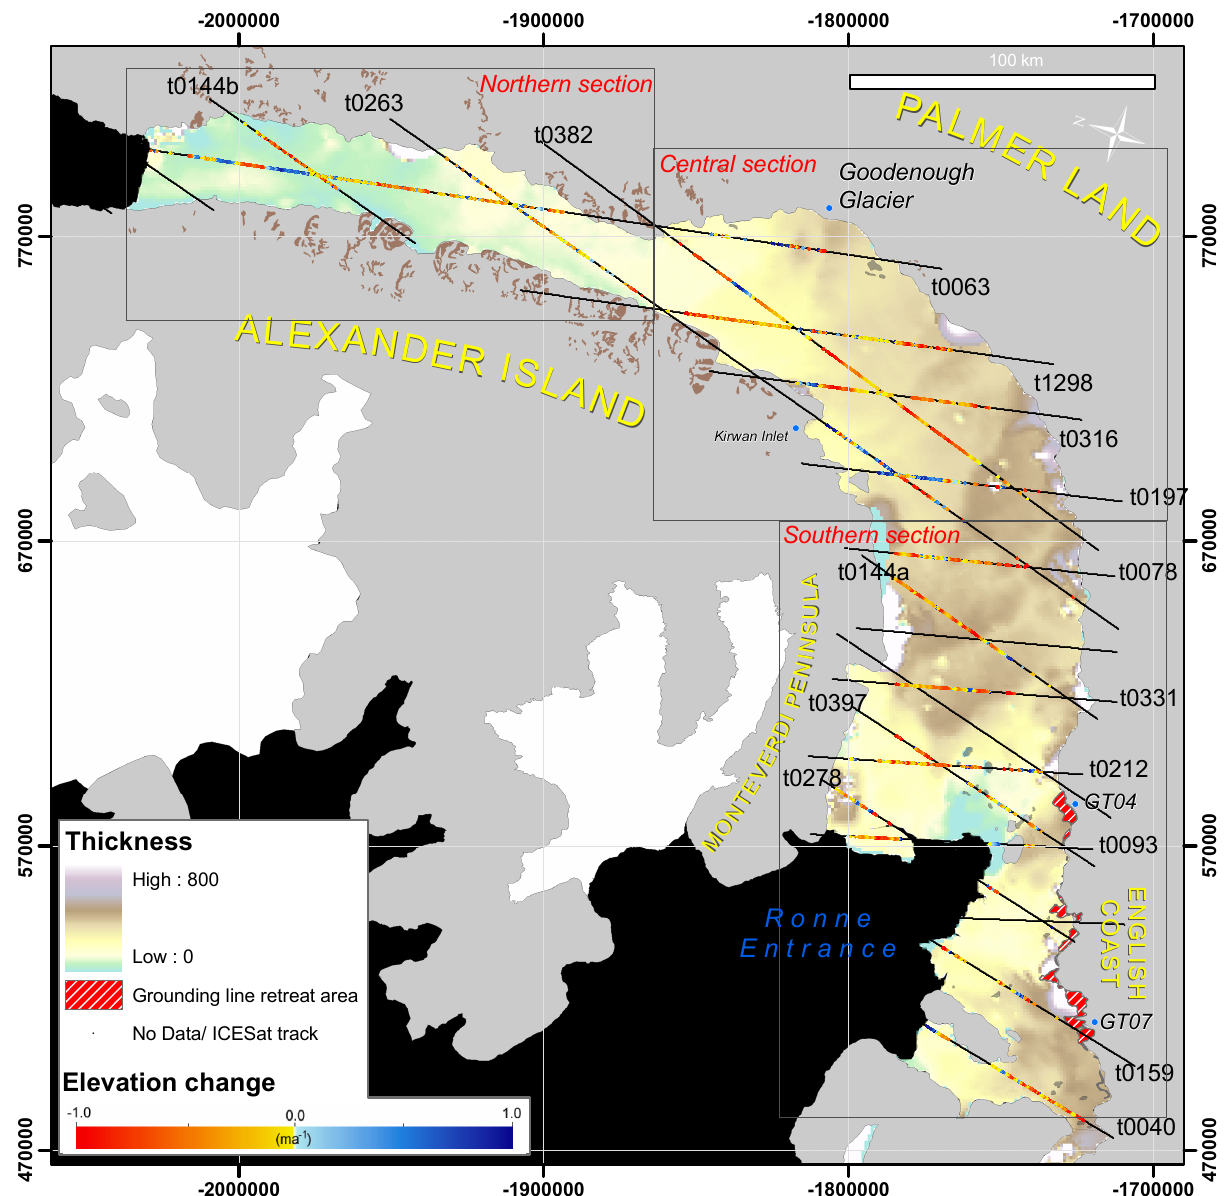
Fig. 8. Surface elevation changes from ICESat’s GLAS repeat measurements (see Table 3 for mean elevation change for each track). A weak, non-significant thinning signal is recorded within the northern section, with distinct pockets of positive elevation change noted towards the ice front. The central section illustrates complex patterns of elevation change, with the greatest losses calculated where ice-shelf draft is thickest. In the southern section, widespread and significant negative elevation change has been calculated, coupled with an observed retreat of the grounding zone between GT04 and GT07 along the English Coast. Ice-thickness data sourced from Griggs and Bamber